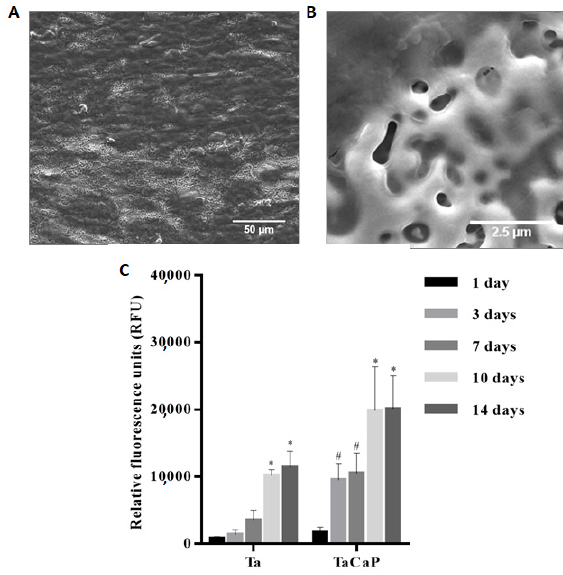
Figure 19. ( A ) Top-view SEM micrographs of MG-63 osteoblastic cells on the MAO-treated Ta surface after culturing for 14 days; ( B ) high magnification image. ( C ) Metabolic activity of MG-63 osteoblastic cells cultured for 14 days over untreated Ta and MAO-treated Ta surface. Significant values as * p ≤ 0.05, compared to the initial adhesion on the sample; # p ≤ 0.05, compared to the control (Ta surface) for the same time point. Adapted with permission from Ref. [74]. Copyright 2021 Elsevier.